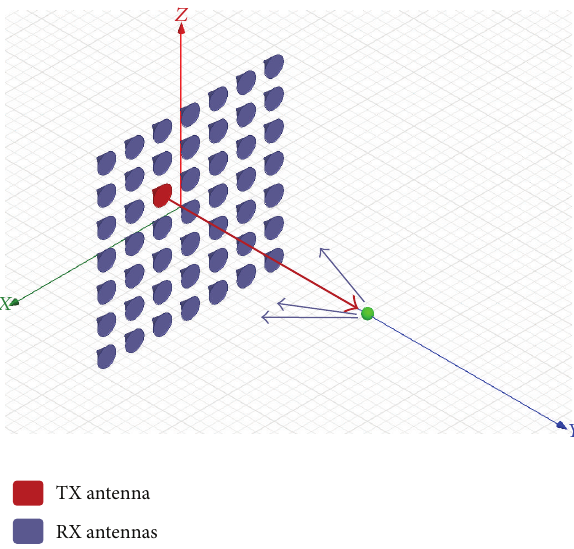
Figure 1: A schematic 7 × 7 antenna